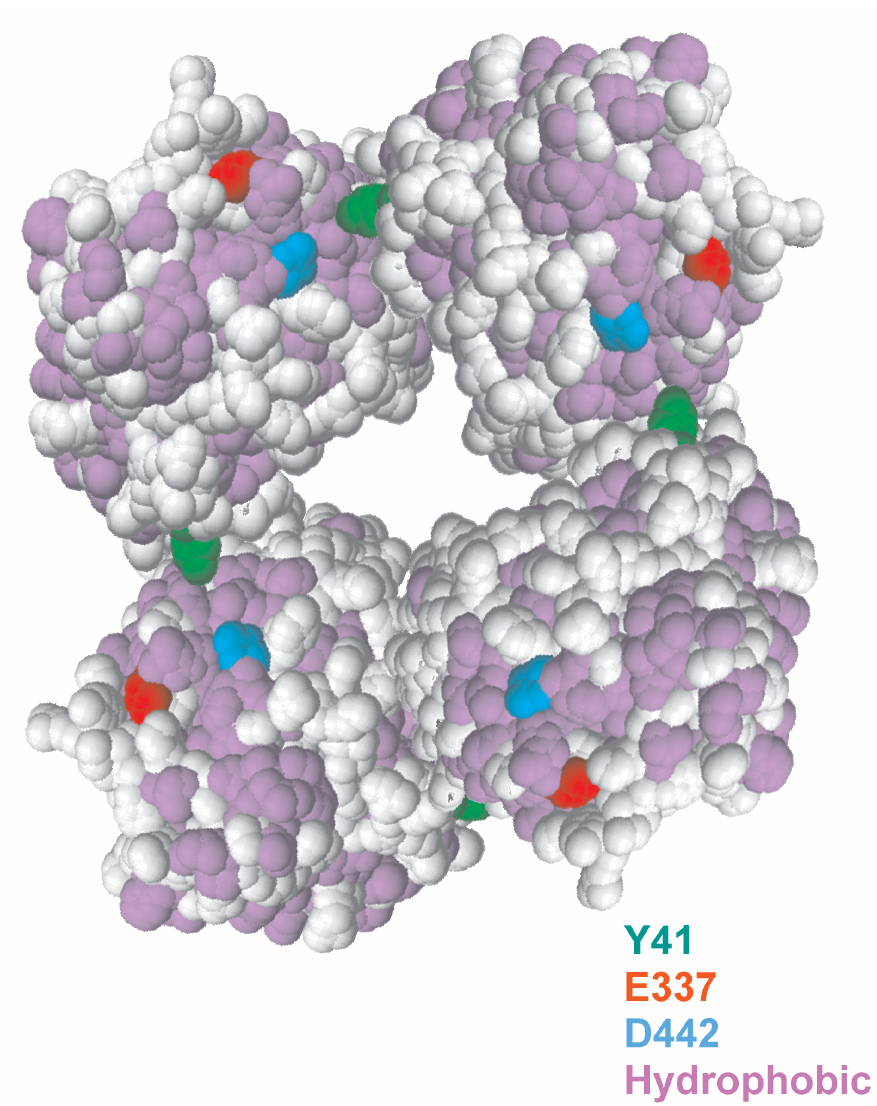
Figure 8. Proposed scheme of the Sulfolobus solfataricus amidase (SSAM) octamer. Each sphere represents a dimer. Hydrophobic residues are in magenta. Also shown are E337 (red) and D442 (light blue) at the entrance to the ac- tive site and Y41 in